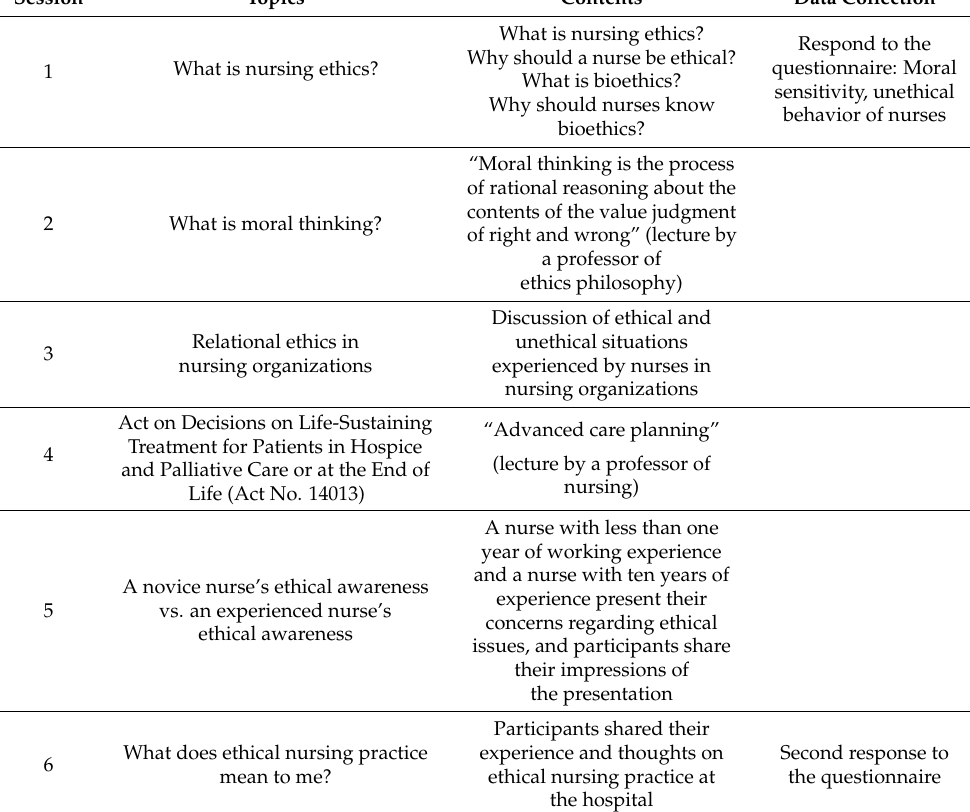
Table 1. Topics for ethics